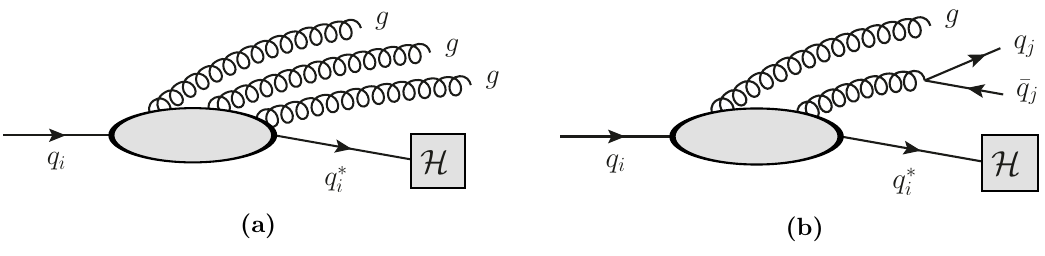
Figure 1. The process q i